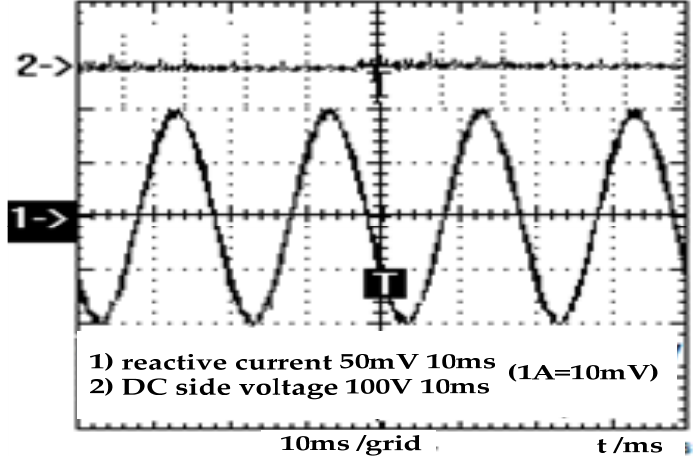
Figure 8. Waveform of DC side voltage and reactive current.